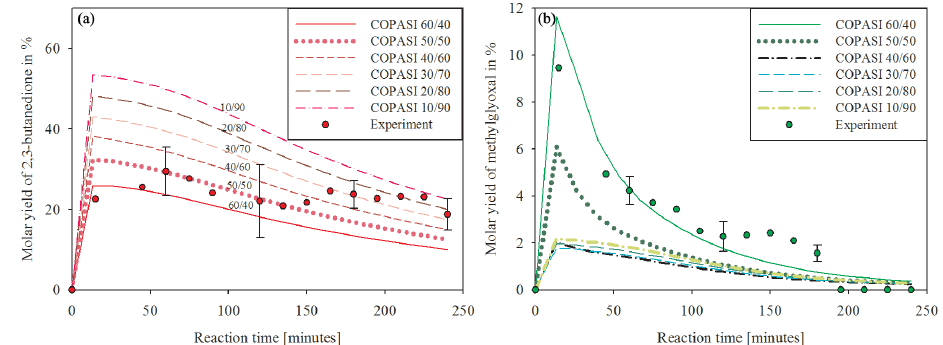
Figure 6. Comparison of the molar yields of 2,3-butanedione (a) and methylglyoxal (b) for the model and experimental results using different branching ratios of the primary/secondary H-atom abstraction varied between 60 / 40 and 10 /